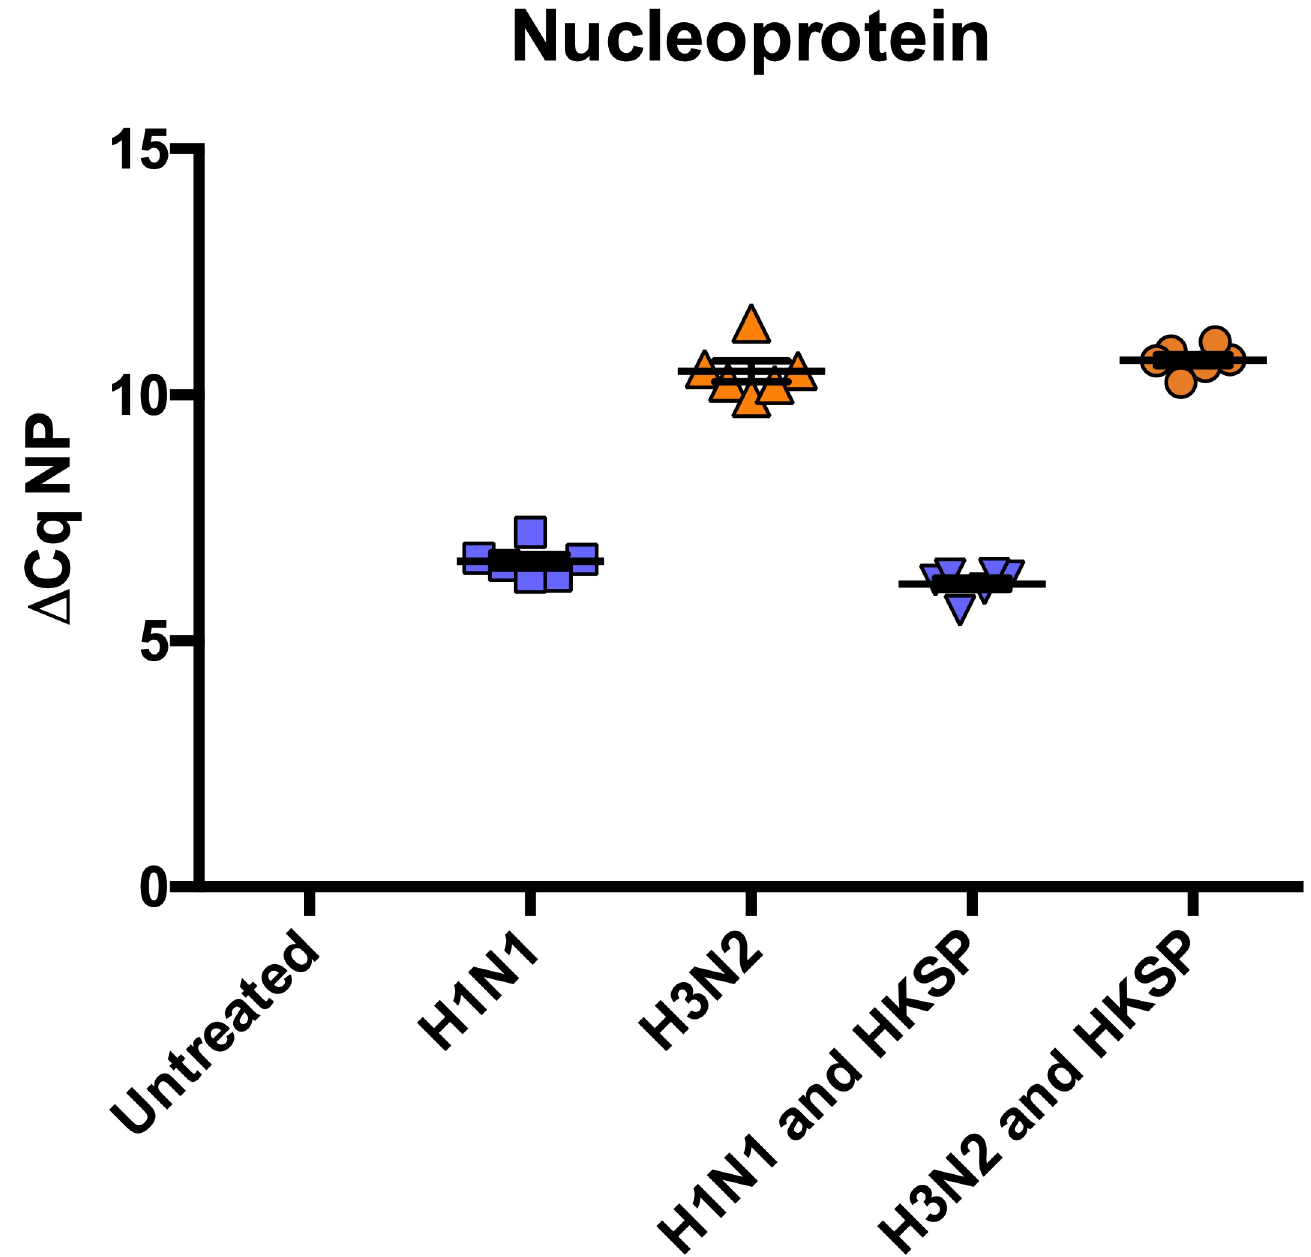
Fig 1. H1N1 and H3N2 are confirmed to infect human monocytes. The levels of H1N1 and H3N2 NP mRNA expression by human monocytes following 24 hr treatment with live H1N1 or H3N2 alone or in combination with HKSP or untreated as a control were determined by qPCR. Cq values were normalised to the expression of GAPDH and plotted on a scatter dot plot, where higher Cq values indicates lower abundance. Each range of dots represents normalised expression of NP + SEM of 2 experimental repeats of each treatment in the same donor (n = 3). Fold expression was not calculated as NP was not amplified in untreated